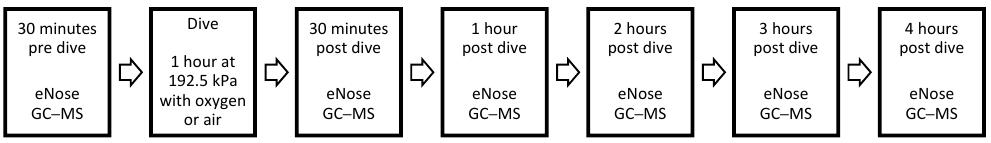
Figure 4. Overview of the study design and data collection. Both study days were identical, the only difference being the type of exposure during the dive (either 100% oxygen or compressed air).